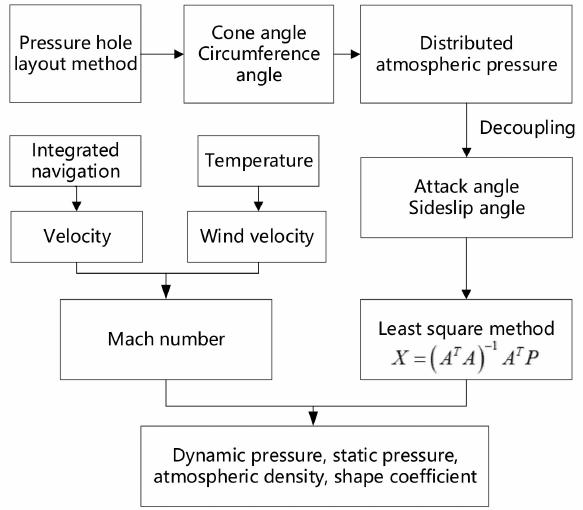
Figure 15. Calculation process of the flush air data sensing